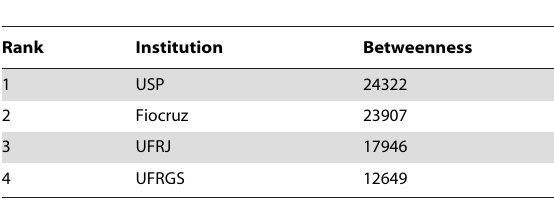
Table 4. Rank of researchers publishing articles on tuberculosis with Brazilian authors, 1995–2010, according to the ‘‘betweeness’’ centrality